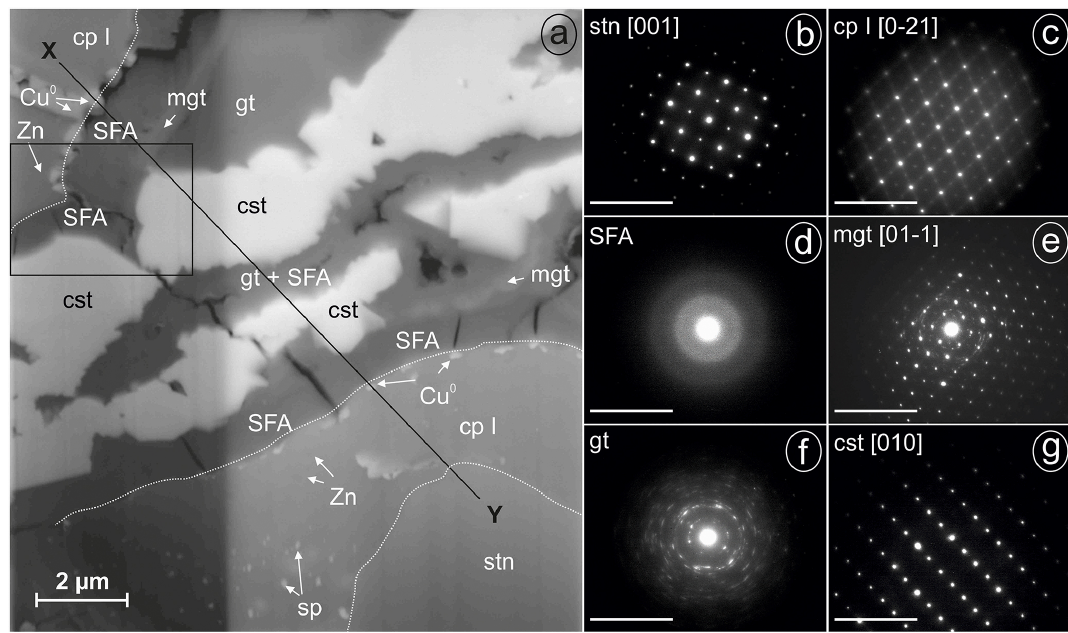
Figure 6. FIB lamella of weathered stannite and SAED patterns of phases (given in reciprocal lattice with 1 / 10nm − 1 scale) from Kaˇnk (cp I, Sn-rich chalcopyrite (chalcopyrite I); cst, cassiterite; Cu 0 , native copper; gt, goethite; mgt, magnetite; SFA, amorphous Sn–Fe–As phase; sp, sphalerite; stn, stannite; Zn, Zn-rich spots): (a) SEM backscattered electron (BSE) image of the lamella with sequences of stannite and secondary precipitates imaged under a tilt angle of 52 ◦ (different brightness along the vertical line resulted from the lamella thickness), (b) SAED pattern of stannite at point Y in Fig. 6a, (c) SAED pattern of chalcopyrite I at point X in Fig. 6a, (d) SAED pattern of SFA, (e) SAED pattern of magnetite, (f) SAED pattern of polycrystalline goethite, and (g) SAED pattern of cassiterite.